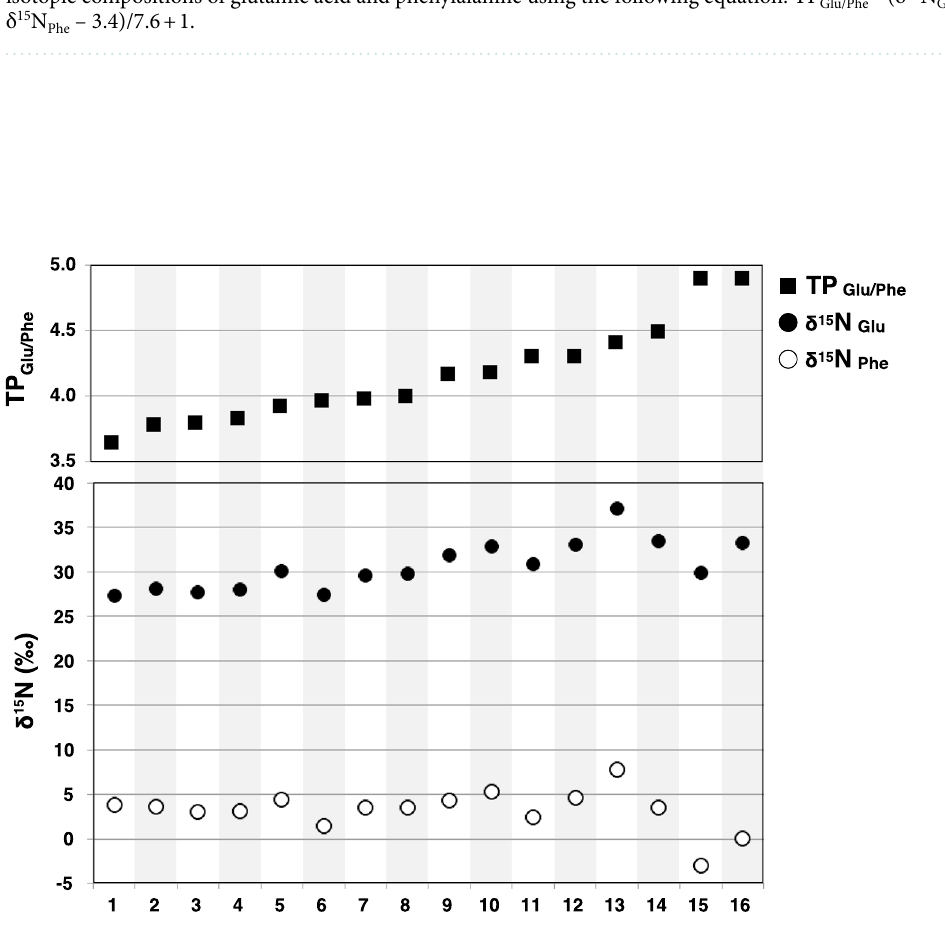
Figure 5. Nitrogen isotopic compositions and trophic positions of deep-sea fish collected in Suruga Bay. Solid circles: nitrogen isotopic compositions of glutamic acid, open circles: nitrogen isotopic compositions of phenylalanine, solid squares: trophic positions (TP) estimated using values of the nitrogen isotopic compositions of glutamic acid and phenylalanine (TP Glu/Phe ). Values of organisms were based on the primary production of phytoplankton. TP Glu/Phe was calculated using Eq. (1) with a β value of − 3.4‰. The numbers shown beneath the graph are the sample numbers indicated in Table